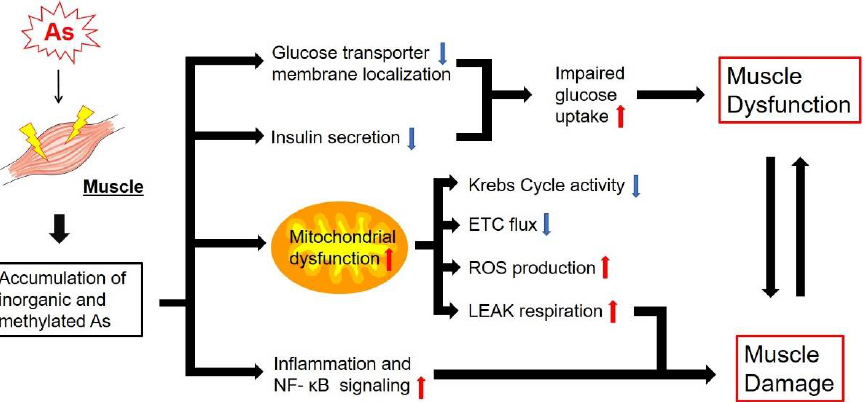
Figure 3. The effects of As on glucose metabolism and mitochondrial function in muscle tissue. When inorganic and methylated (organic) As are generated upon As absorption by muscle tissue, accumulated As species alter glucose metabolism and cause mitochondrial dysfunction. Accumulated As species also cause inflammation via NF- κ B signaling in muscle tissue. As toxicity triggering muscle dysfunction and damage worsens metabolic-disease-associated pathologies. Note: ETC, electron transport chain; ROS, reactive oxygen species. The red arrow indicates an increased effect, while the blue arrow indicates a decreased